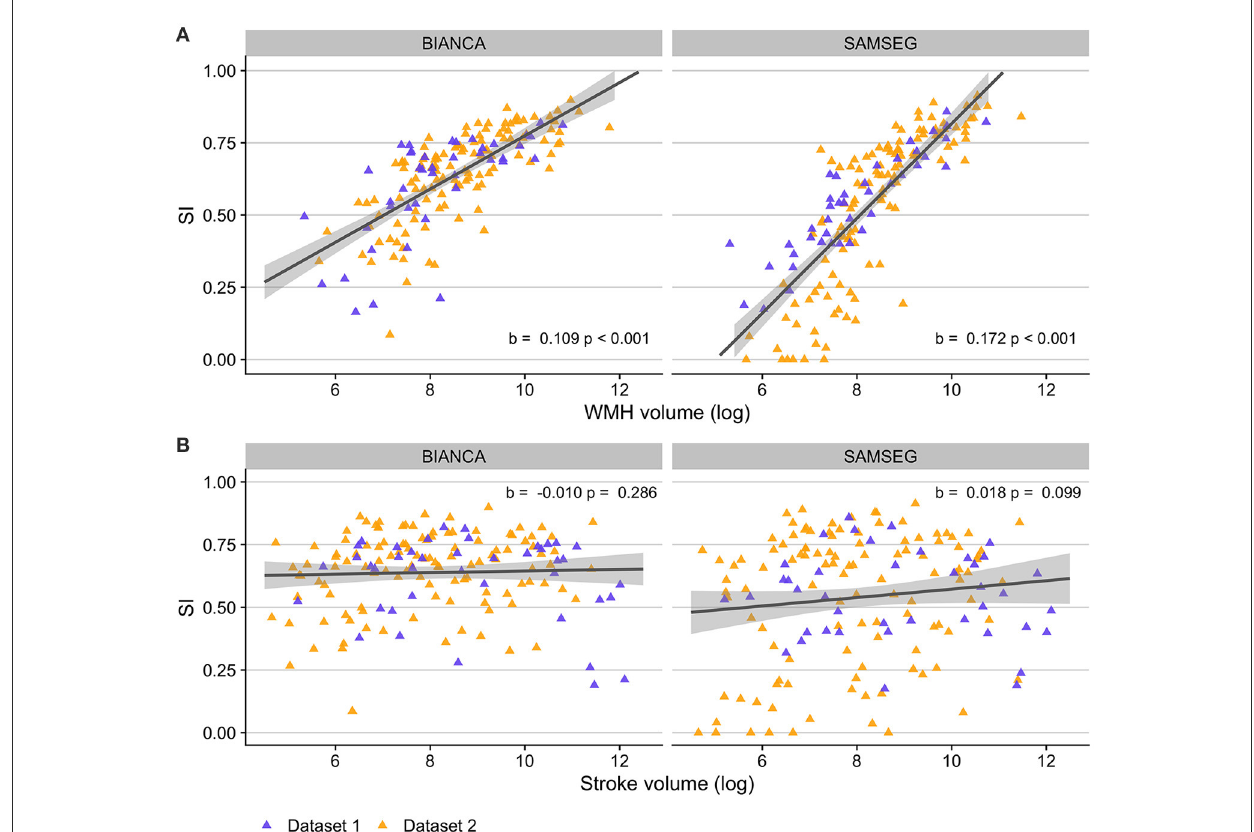
FIGURE7 Relationships between automated WMH segmentation performance (indexed by Dice similarity index; SI) and lesion volumes in individuals with stroke. (A) Individuals with higher WMH volumes had better automated WMH segmentation accuracy with both BIANCA (left) and SAMSEG (right) segmentation algorithms. (B) WMH segmentation accuracy did not relate to stroke volumes for either BIANCA or SAMSEG segmentation. Dataset 1: cohort of individuals with chronic stroke; Dataset 2: cohort of individuals with subacute stroke.